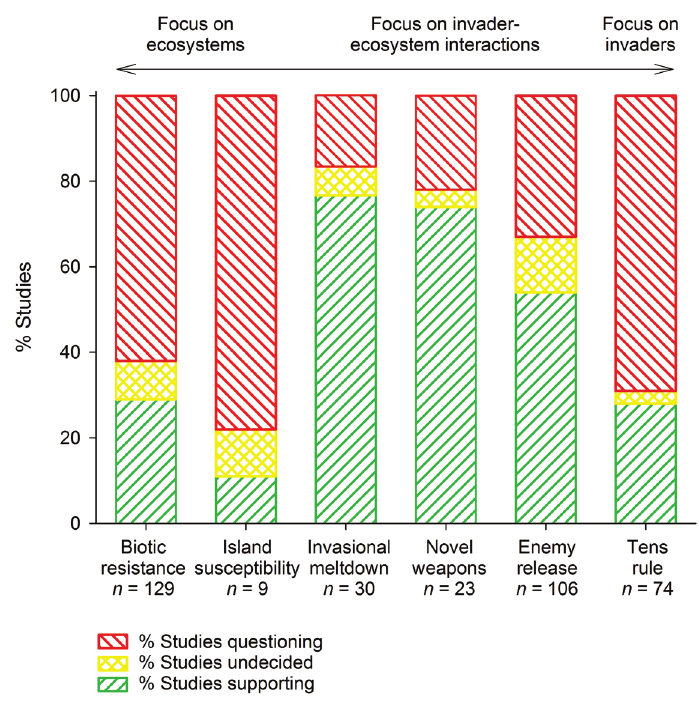
Figure 2. Overall level of empirical support for six of invasion biology’s major hypotheses. Hypotheses focusing on ecosystems where invaders were introduced are on the left (biotic resistance, island suscepti- bility), the tens rule which focuses on the invaders themselves is on the right, and hypotheses considering invader-ecosystem interactions are in between (invasional meltdown, novel weapons, enemy